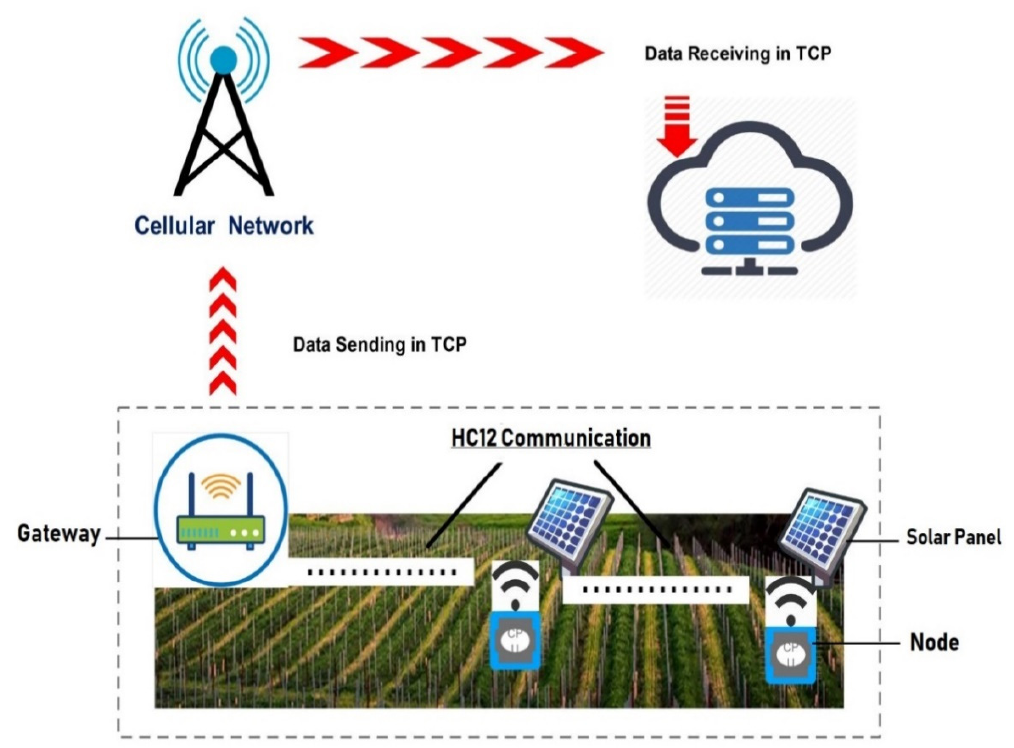
Figure 1. Block diagram of IoT-based agriculture farm.